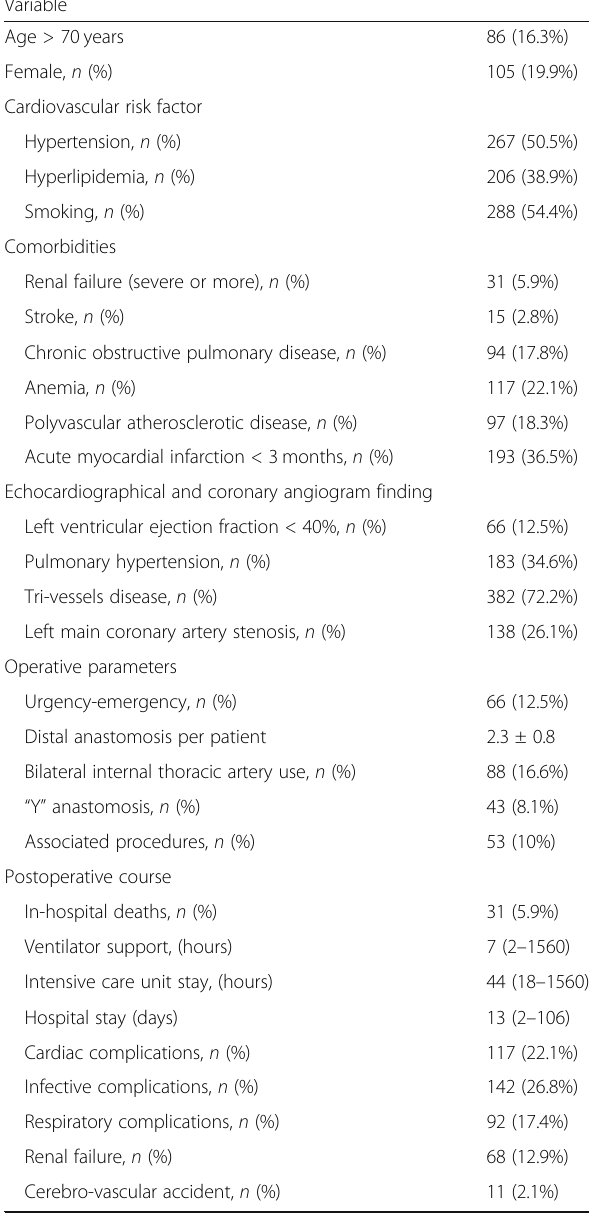
all patients. Data are expressed as n (%) for categorical variables, mean ± standard deviations, or median (range) for continuous